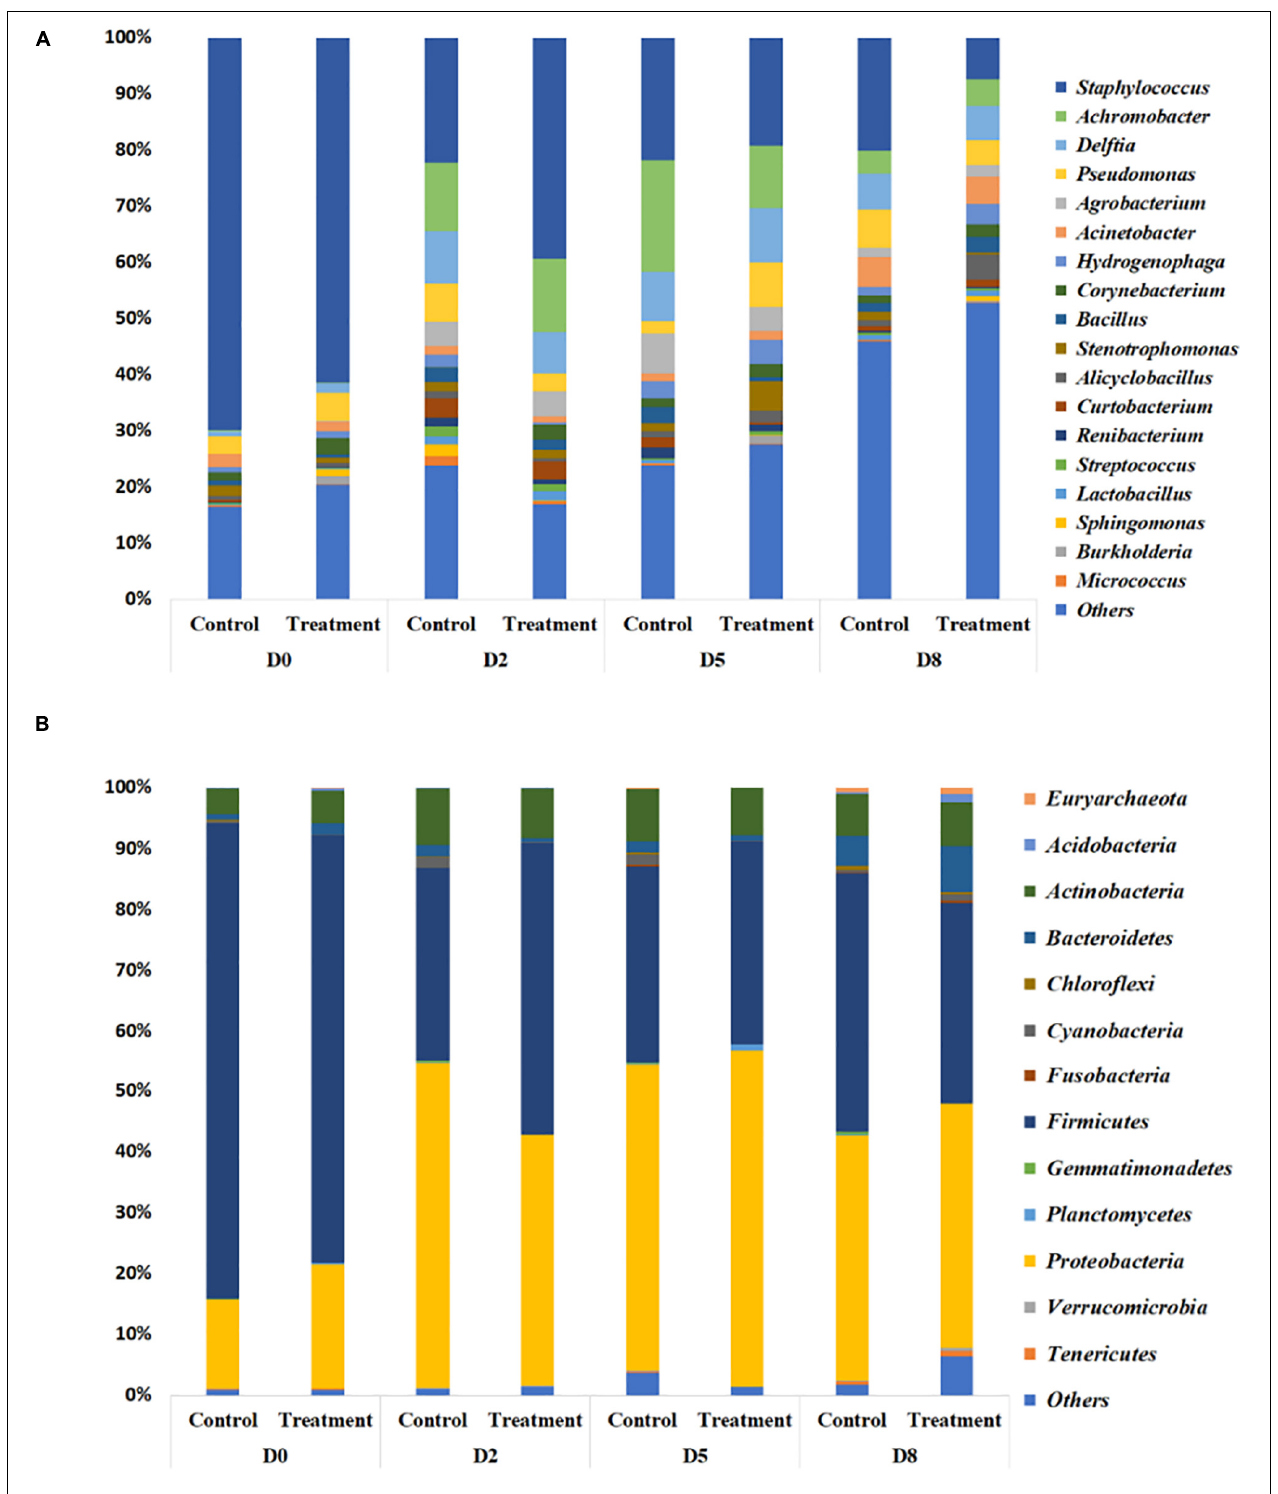
FIGURE 6 | Relative abundance of bacteria in milk from cows with clinical mastitis at the genus level (A) and the phylum level (B) , with or without B. velezensis AP183 probiotic treatment, based on 16S rRNA gene amplicon sequencing. The treatment group corresponds to bovine quarters treated with both S. aureus RF122 and B. velezensis AP183, whereas the control group corresponds to treatment with S. aureus RF122 alone. D o , Day before the treatment; D 2 , 2 days post treatment; D 5 , 5 days post treatment; D 5 , 8 days post treatment. The most abundant taxa were sorted by descending order of relative abundance; remaining phylum and genera were grouped as ’Others.’ Each bar plot of the corresponding category in both phylum and genus level represents the relative abundance of bacteria in each sample.